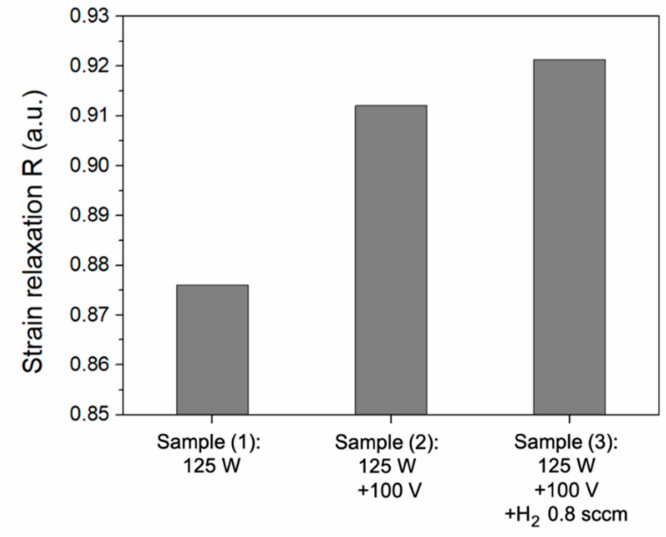
Figure 3. The compressive strains of the Ge films.